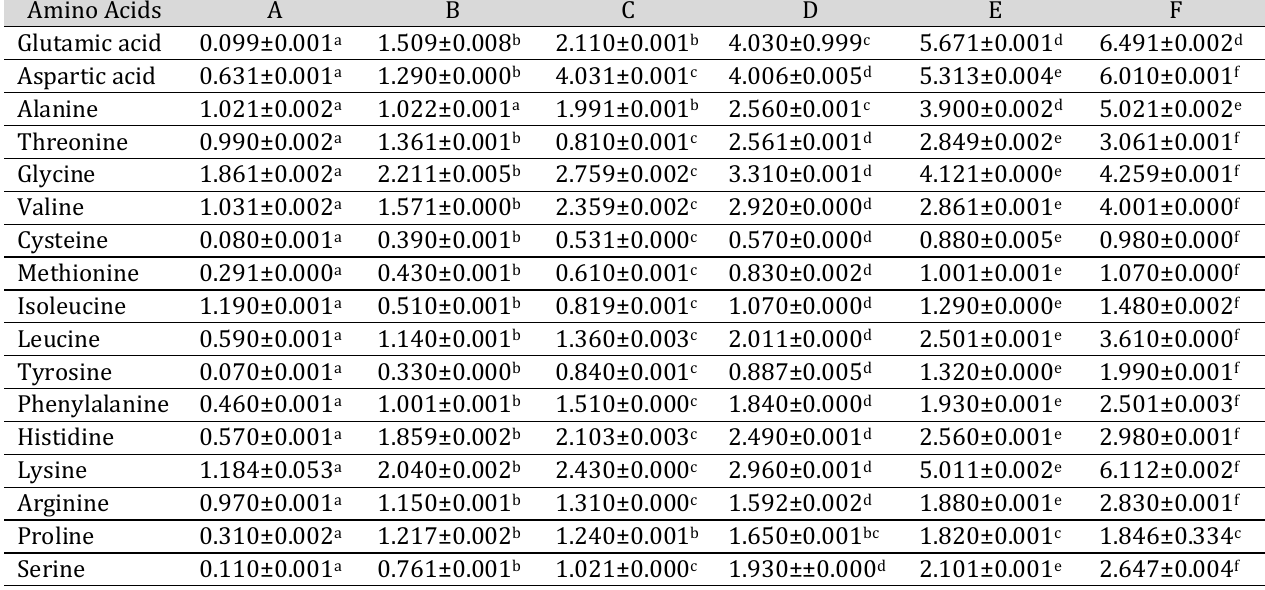
Table 4. Amino acid composition of fermented blends of Cassava-African yam bean (g/100g).